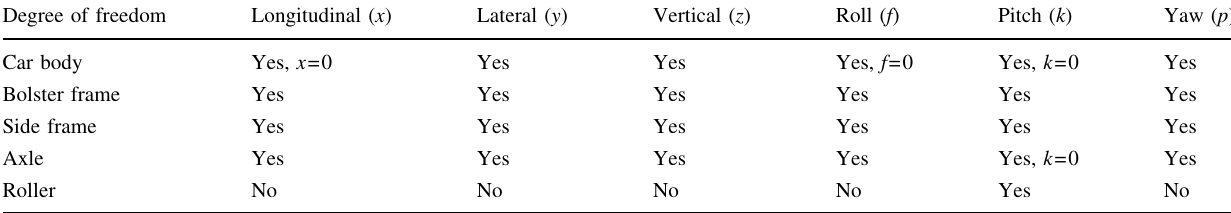
Table 2 Constraints on bodies